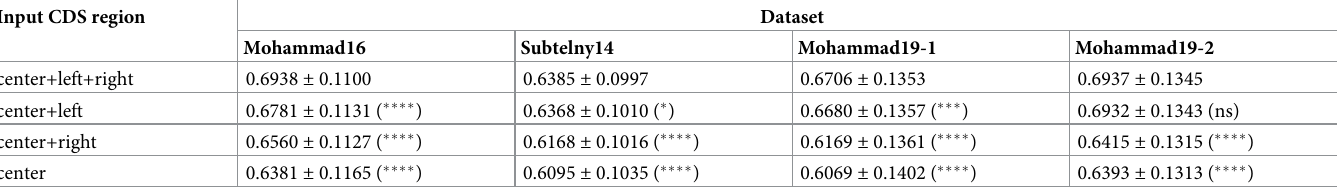
10-fold cross-validation through randomly splitting genes into training and test sets was performed on the four datasets to assess the performance of each input region. The gene-wise correlations were computed by comparing the predicted and measured ribosome densities for individual genes in the test set at each 10-fold cross- validation. The mean ± SD of the gene-wise Pearson’s correlation coefficients across the whole dataset are shown. Significant levels from Friedman tests with Dunn’s multiple comparison correction are shown in the parentheses. The statistical tests were conducted by comparing the RiboMIMO models using parts of the CDS regions as input with that using full-length CDS regions. The notations of CDS regions (i.e., “center”, “left” and “right”) are defined in both Fig 1D and main text.